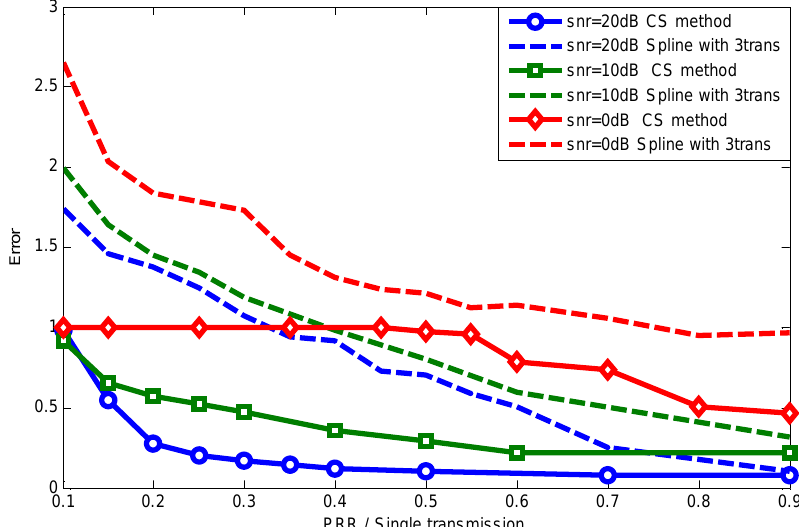
Figure 17. Signal reconstruction error comparison with noise